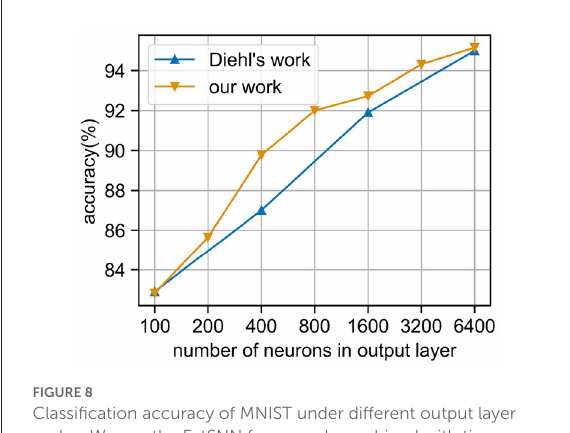
FIGURE8 Classification accuracy of MNIST under different output layer scales. We use the EvtSNN framework combined with time coding for simulation, and the accuracy is no less than the Brian framework and frequency coding in Diehl’s paper.